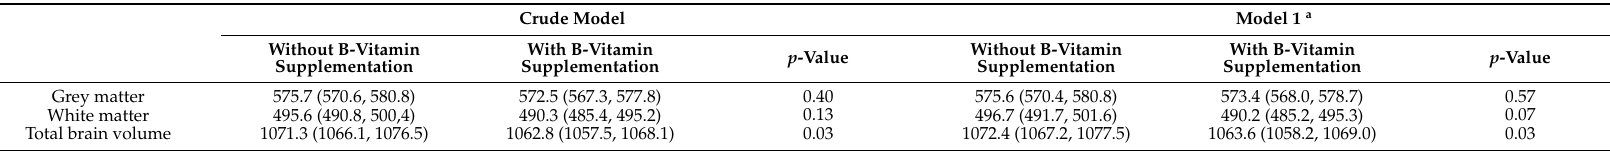
Crude: Adjusted for intracranial volume, age, sex; Model 1: Adjusted for model 1 and BMI, alcohol, smoking, education, physical activity; a n = 214; b n = 208; c n = 205; d n = 212; e Table 3. Differences in brain volumes (mL) between participants who received two-year B-vitamin supplementation ( n = 106) and participants who did not receive this supplementation ( n = 112) (adjusted means (95% confidence